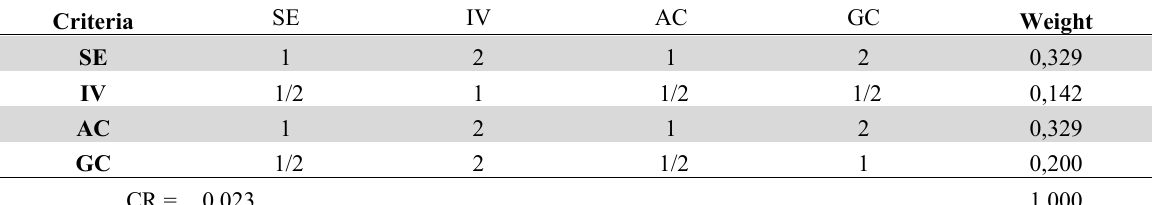
Pairwise comparison matrix aggregation for Vulnerability